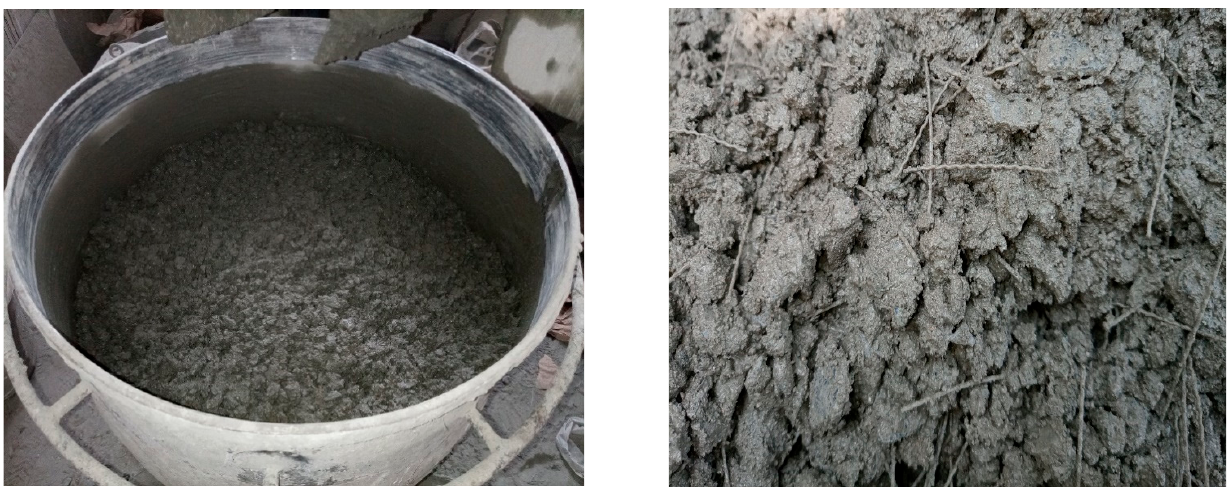
Figure 4. Pan ‐ type mixer used for mixing of concrete. Figure 4. Pan-type mixer used for mixing of